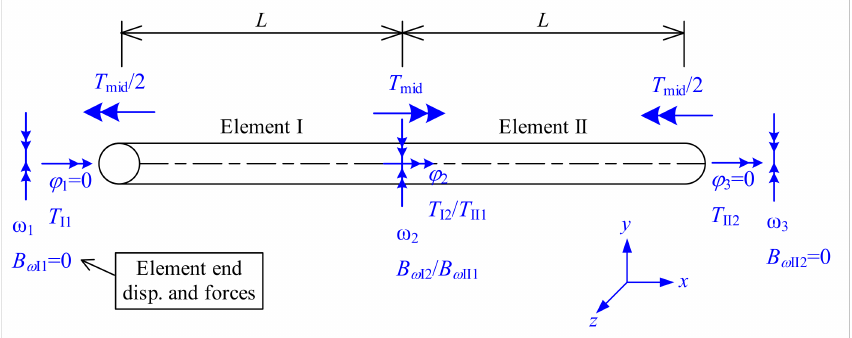
Figure 6. Analysis of torsion and warping of a torsion member with a midspan